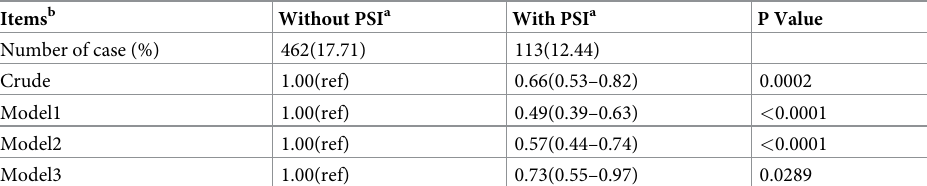
Table 3. Analysis on the associations between PSI and hyperuricemia.